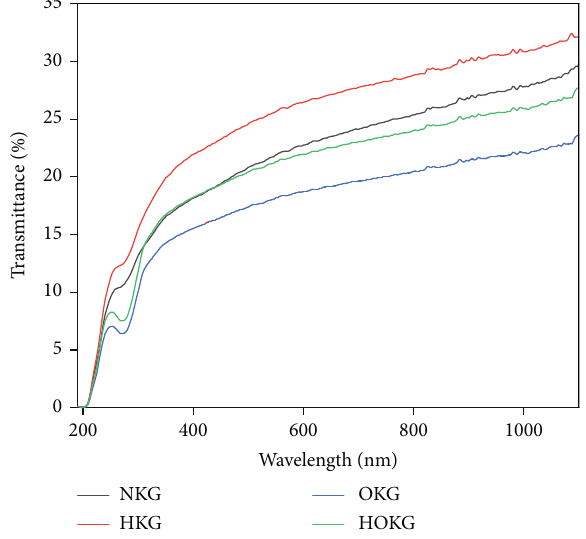
Figure 6: UV-vis spectra of starch-KG fi